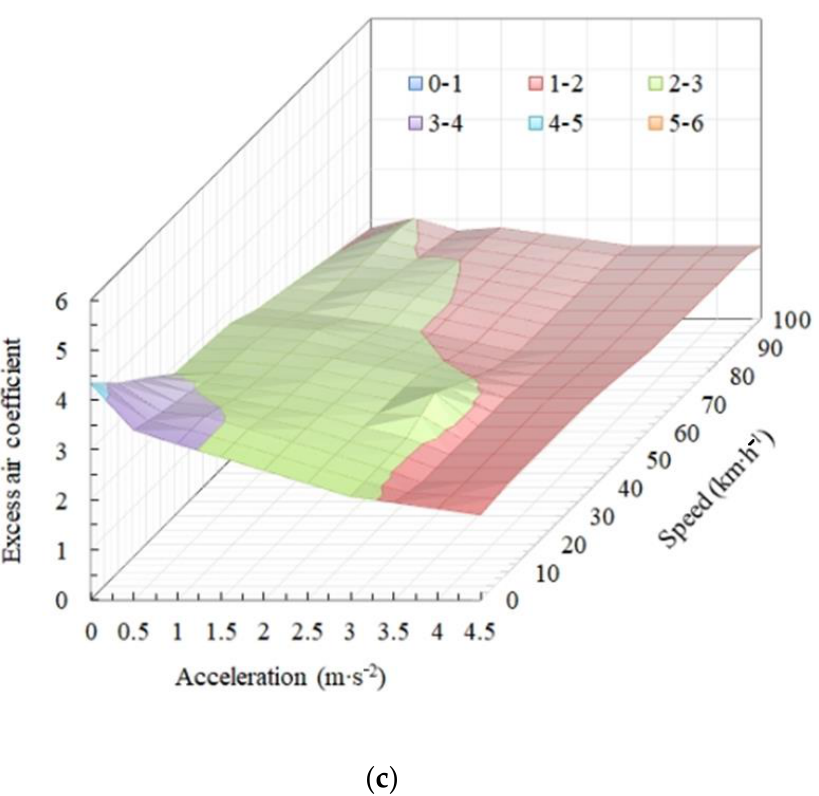
Figure 2. Excess air coefficient map as a function of vehicle speed and acceleration. ( a ) Excess air coefficient map for light-duty diesel vehicle. ( b ) Excess air coefficient map for medium-duty diesel vehicle. ( c ) Excess air coefficient map for heavy-duty diesel vehicle.